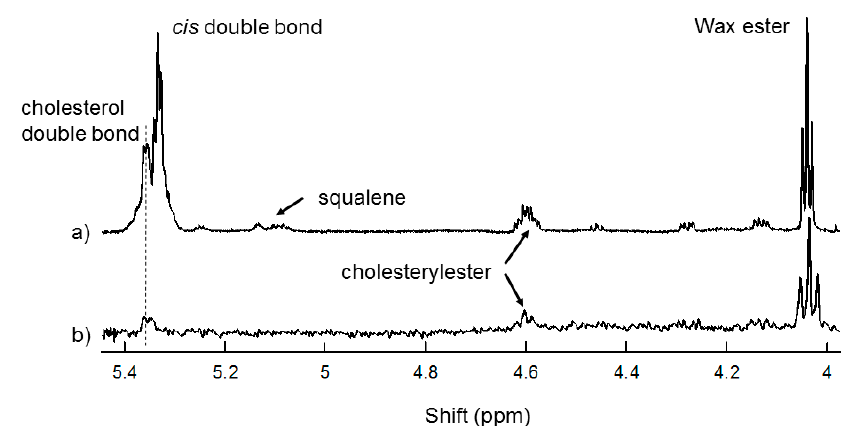
Figure 1. 1 H-NMR spectrum of tear lipids from ( a ) a 63-year-old Caucasian male with no dry eye. ( b ) 1 H-NMR spectrum of tear lipids in Figure ( a ) that were catalytically saturated. Note that there are no cis hydrocarbon chain double bonds in the saturated sample spectra.